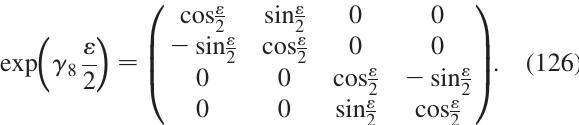
As listed in Table III, the matrices (cid:1) alternative basis to (cid:1) produced by (cid:1) dard basis and this first alternative